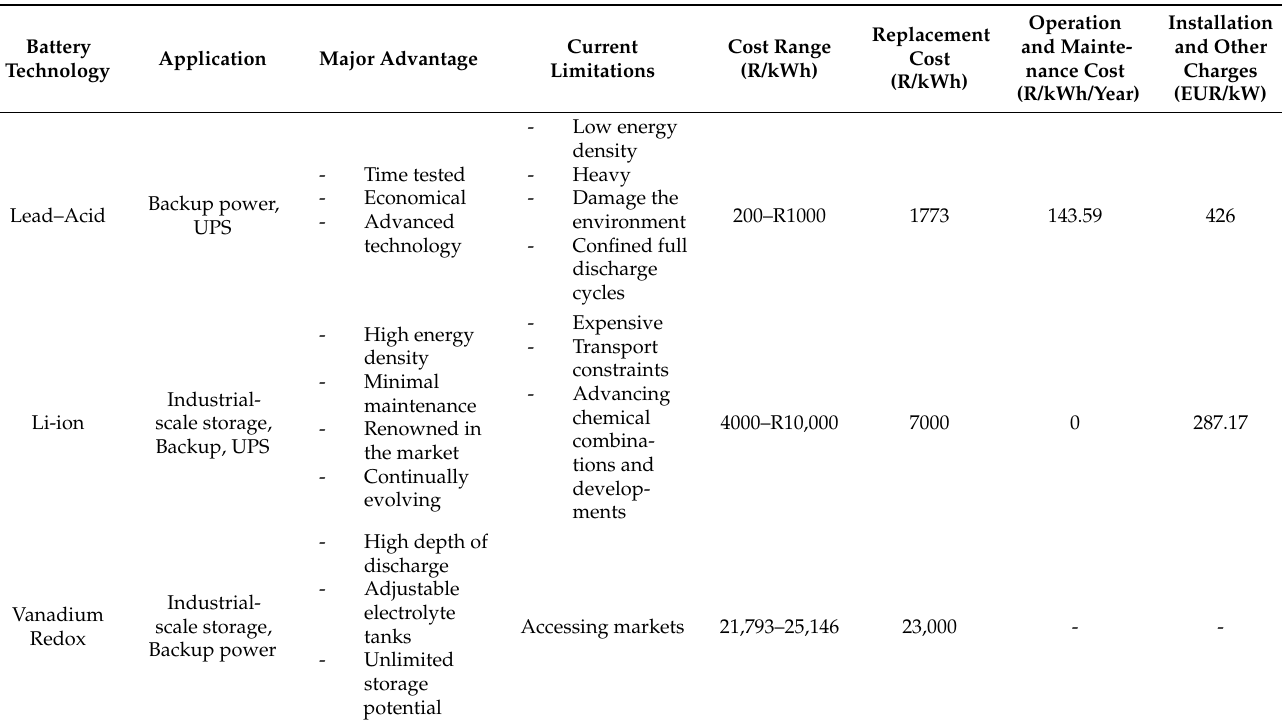
Table 3. BESS in South African Market